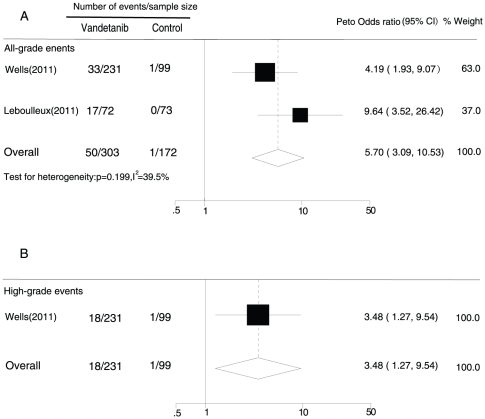
Peto Odds ratio of vandetanib-associated all grade (A) and high-grade (B) prolonged QTc interval versus control from the randomized controlled trials of patients with thyroid cancer.